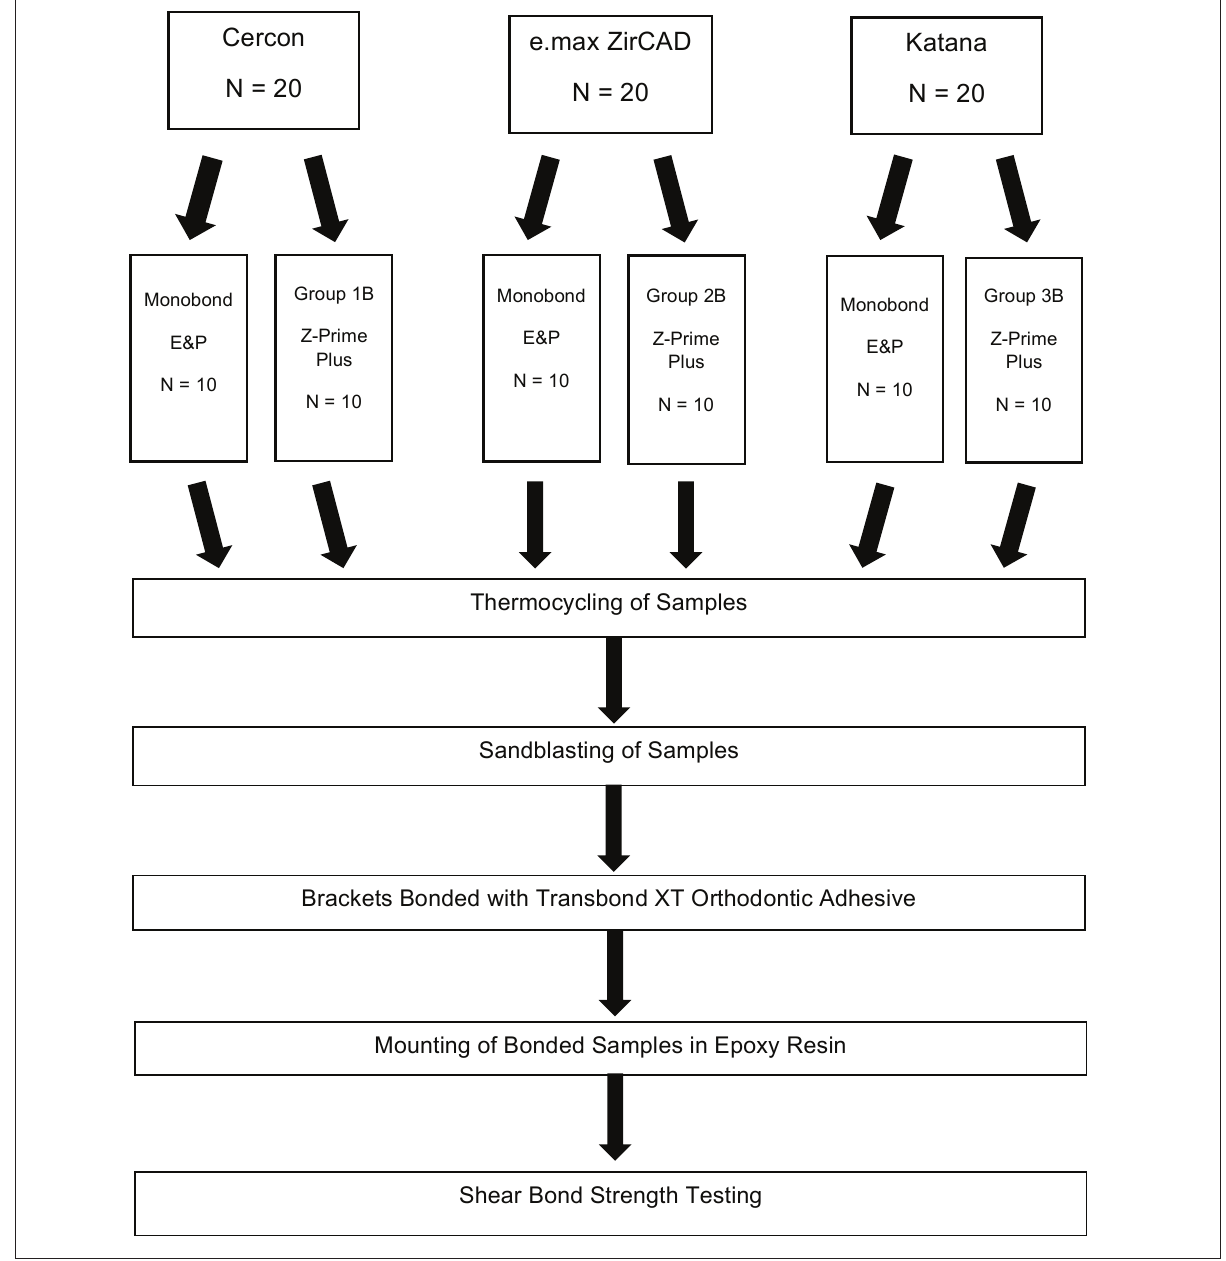
Figure 1. Research